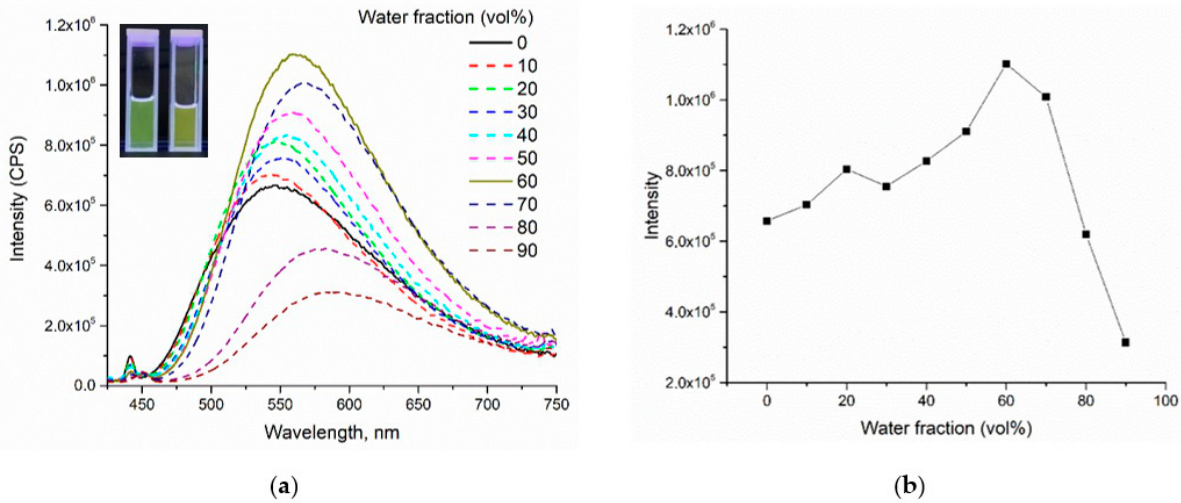
Figure 5. Emission spectra of 6c in different ratios of THF–water (v/v) mixtures ( a ). Plot of I/I 0 versus water fraction (vol%), where I 0 is the fluorescence intensity in pure THF and emission images of the 6c in different water fraction mixtures under 365 nm UV illumination ( λ ex = 365 nm) with the concentration of 10 − 5 M ( b ).